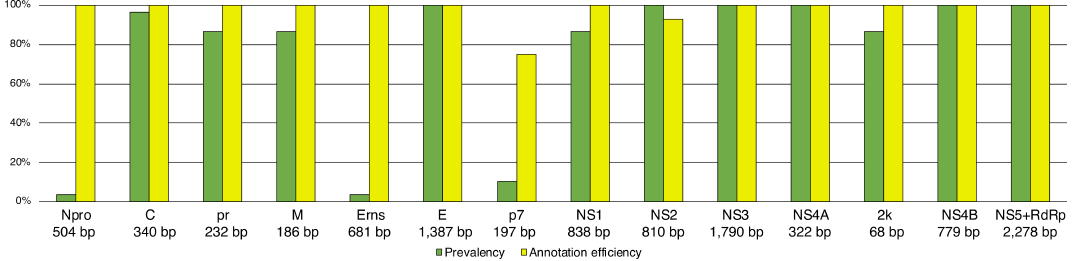
Figure 3. Efficiency of annotation pipeline and partition prevalence. The calculation of efficiency and prevalence considers 63 fully annotated reference sequences from the genera Flavivirus (48 sequences), Hepacivirus (seven sequences), Pegivirus (four sequences), and Pestivirus (four sequences). Prevalence is a measure of how widespread the partition is among the 63 annotated reference genomes. Annotation efficiency is a measure of the number of correct annotations when comparing the results with the 63 fully annotated reference genomes included in this study. There were no false positives. Values below each partition indicate their average length among the selected